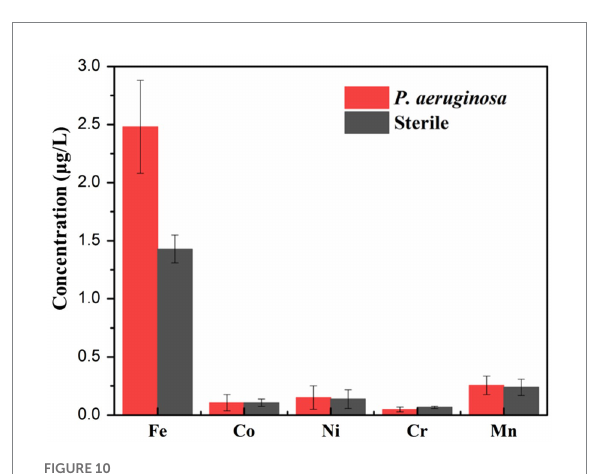
FIGURE 10 The concentrations of metallic ions dissolution from the HEA coupons in the sterile and the P. aeruginosa -inoculated medium after 14